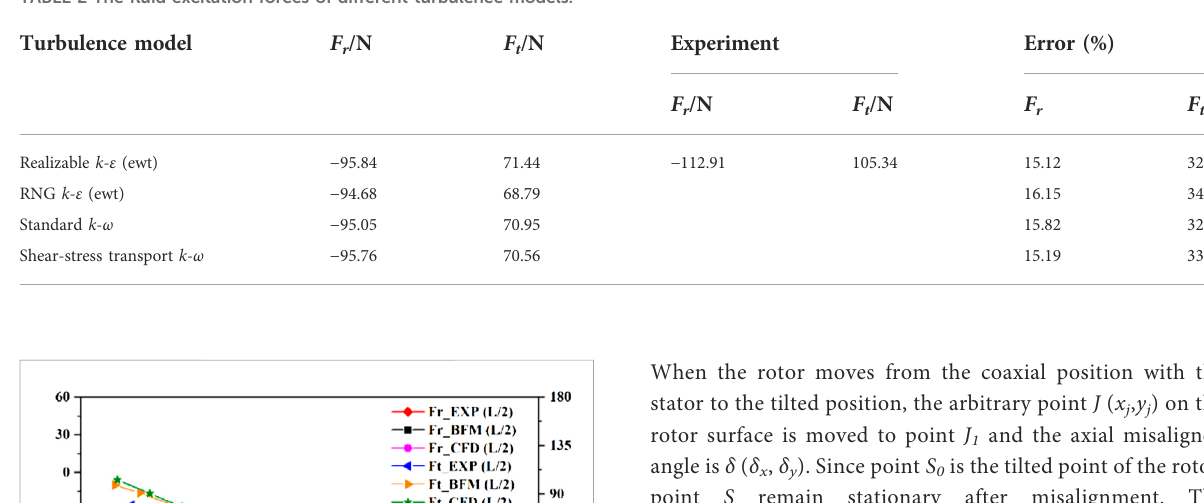
TABLE 2 The fl uid excitation forces of different turbulence models.